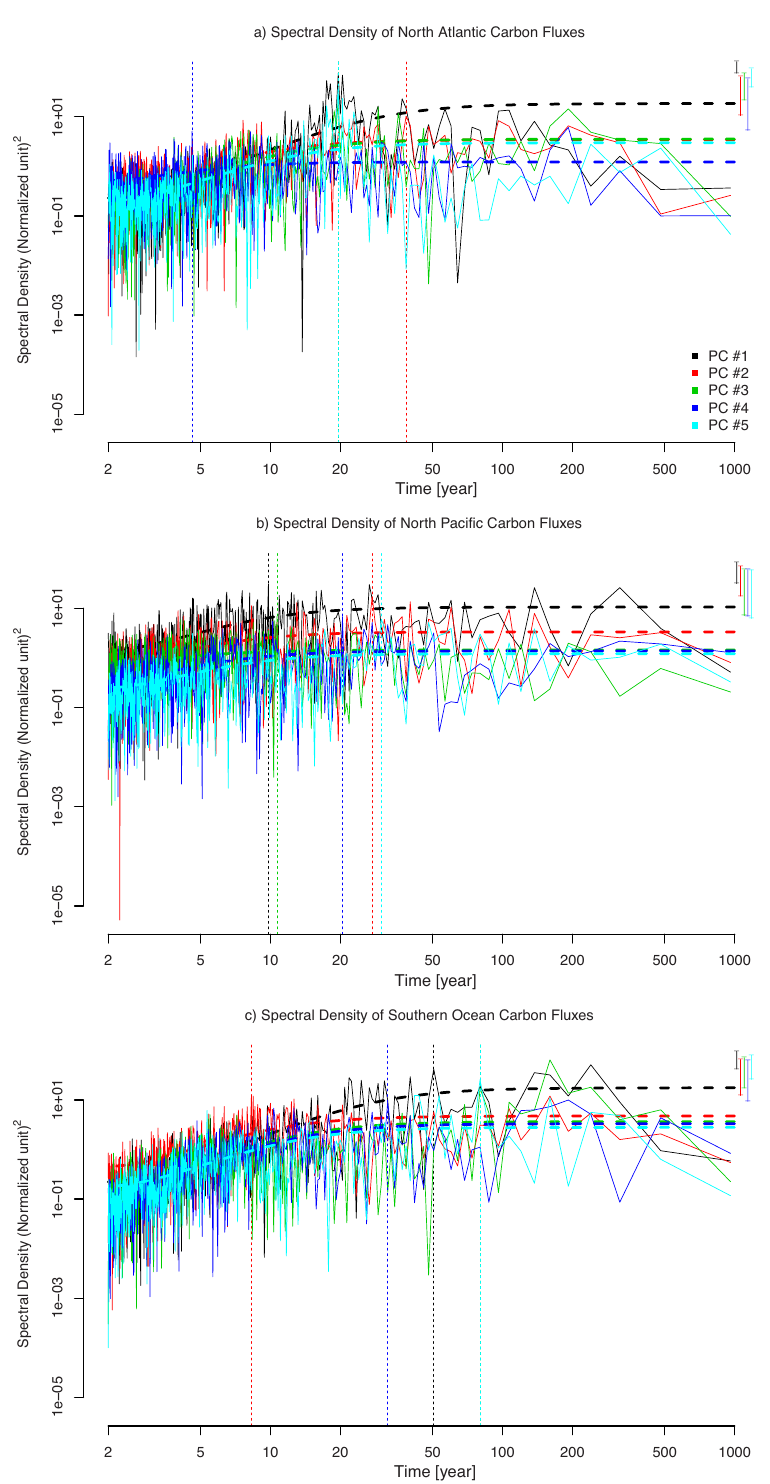
Fig. 4. Scaled spectral density of the five leading principal components of ocean carbon fluxes for (a) the North Atlantic (10 ◦ N–80 ◦ N), (b) the North Pacific (10 ◦ N–70 ◦ N) and (c) the Southern ocean( < 50 ◦ S). Dashed lines represent fitted AR1 theoretical spectrum according to the Yule-Walker estimation, while the linear dashed lines indicate the maximum of spectral density for each principal component. Confidence intervals at 95% of significance of the scaled spectral density maximum are indicated by vertical bars; they have been computed from a (scaled) χ 2